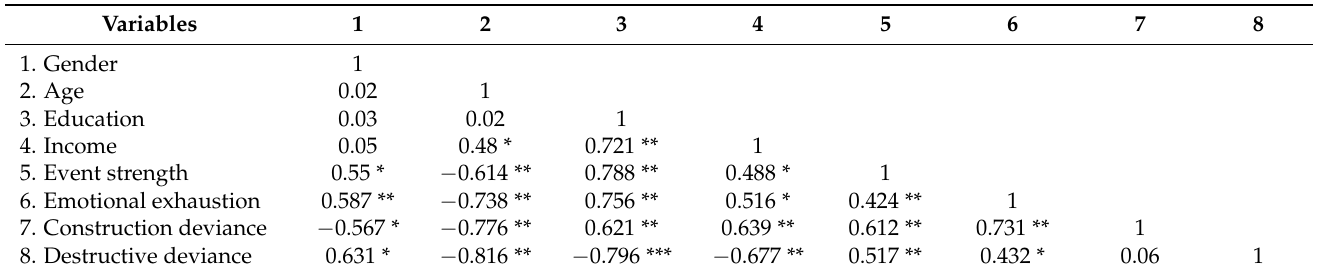
Table 3. Variable correlation